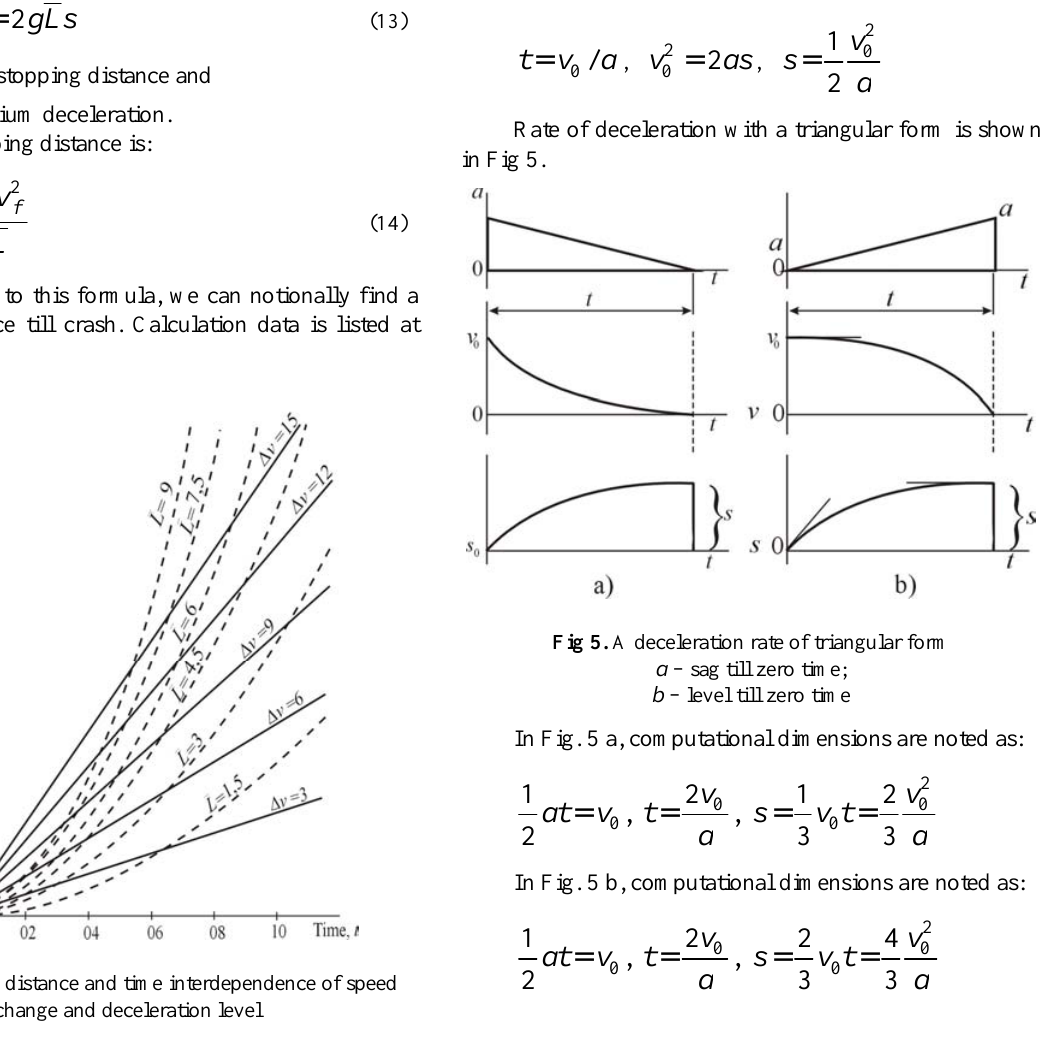
Fig 4. Rate of deceleration with a rectangular form Here